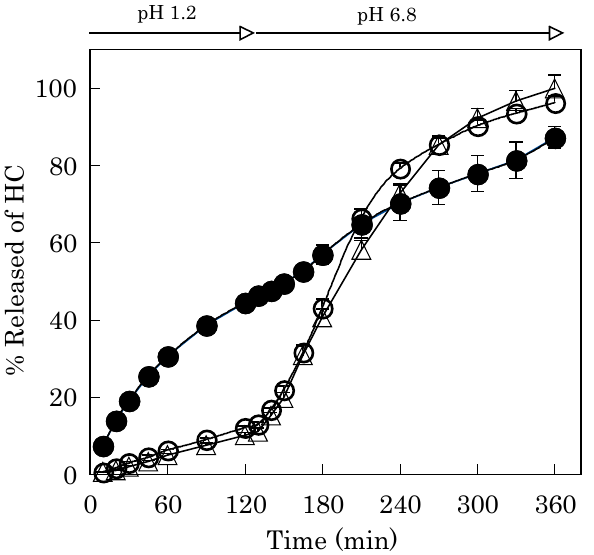
Figure 5. HC-Release curves from Alg-Ca containing CS and